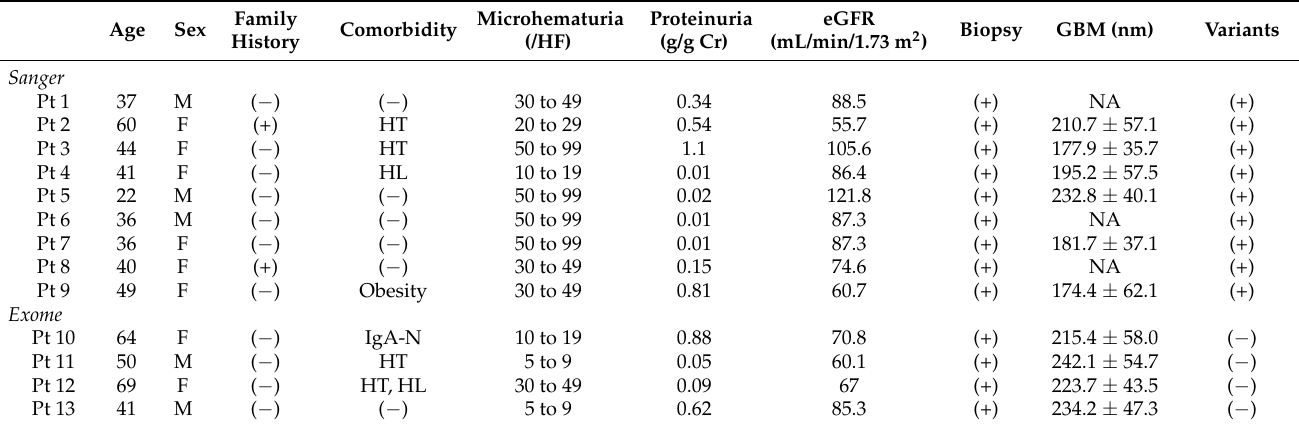
Table 1. Clinical characteristics of the study